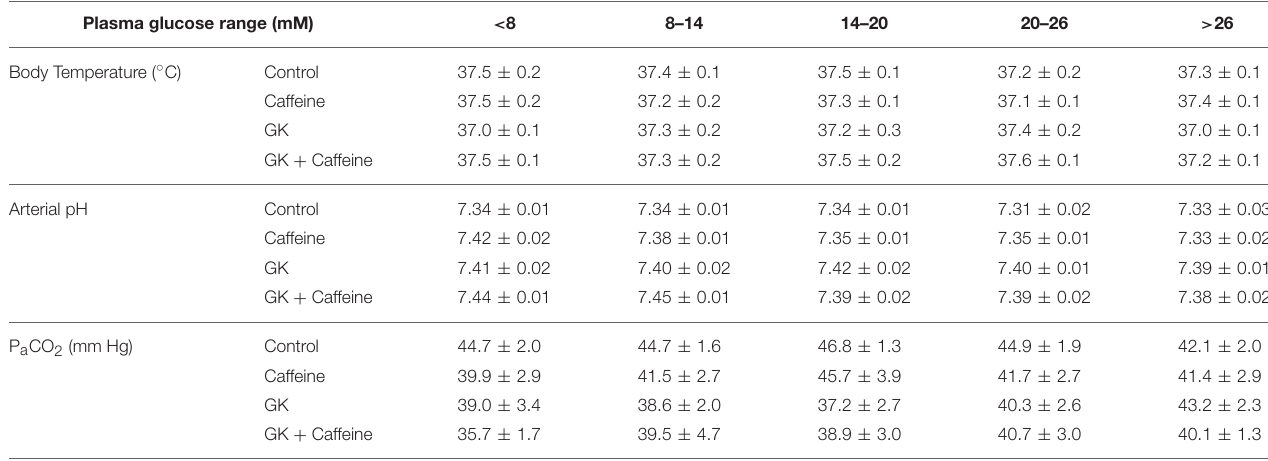
TABLE 1 | Mean physiologic parameters measured at 5 different intervals of steady-state plasma glucose concentration in MRS experiments. Plasma glucose range (mM)